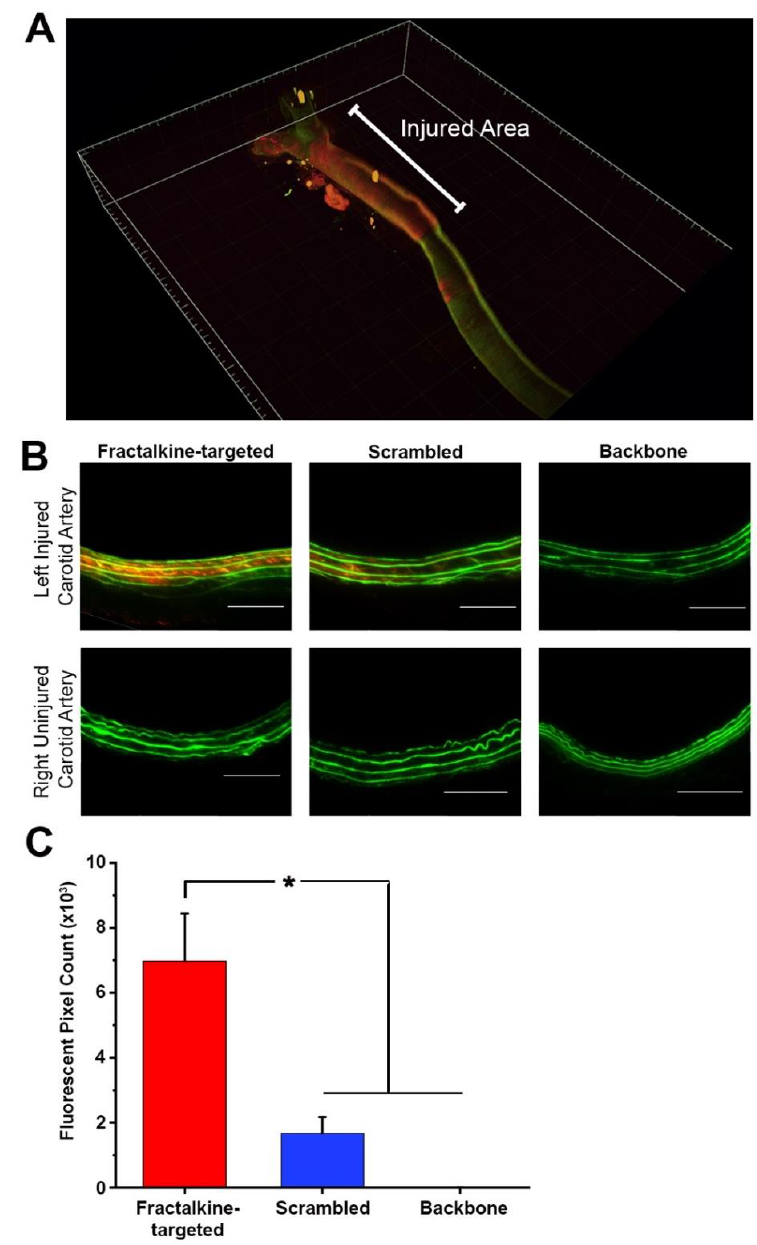
Figure 3. Fractalkine-targeted nanofiber localizes to the medial surface of left injured carotid artery and in greater amounts compared to control peptide amphiphiles, without localizing to the uninjured right carotid artery. ( A ) Three-dimensional light-sheet fluorescence microscopy exhibiting localization of fractalkine-targeted nanofiber to the injured area (B ) Fluorescent microscopy of left injured and right uninjured carotid arteries show localization of fractalkine-targeted nanofiber to injured site (red), minimal localization of the scrambled nanofiber, and no localization of the backbone nanofibers to the injured site. Green = autofluorescence of arterial lamina and red = TAMRA-tagged nanofiber. Magnification, 20 × ; n = 4 / treatment group; scale bar = 100 µ m. ( C ) Quantification of fluorescence demonstrates localization of fractalkine-targeted PA to the injured artery compared to control nanofibers at the injured site, * p <